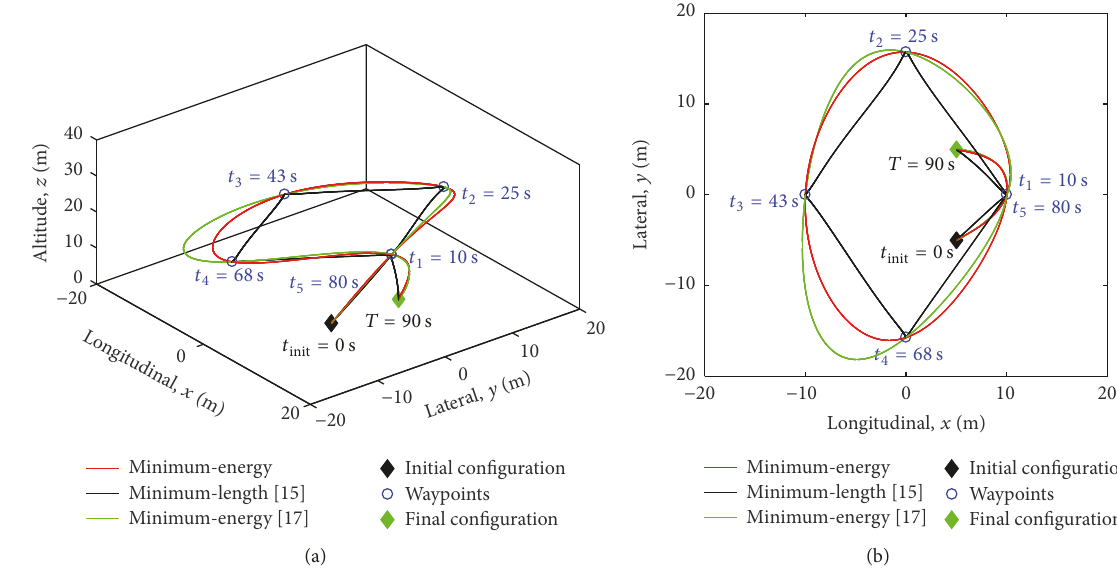
Figure 3: Optimal 3D and 2D reference flight trajectory.